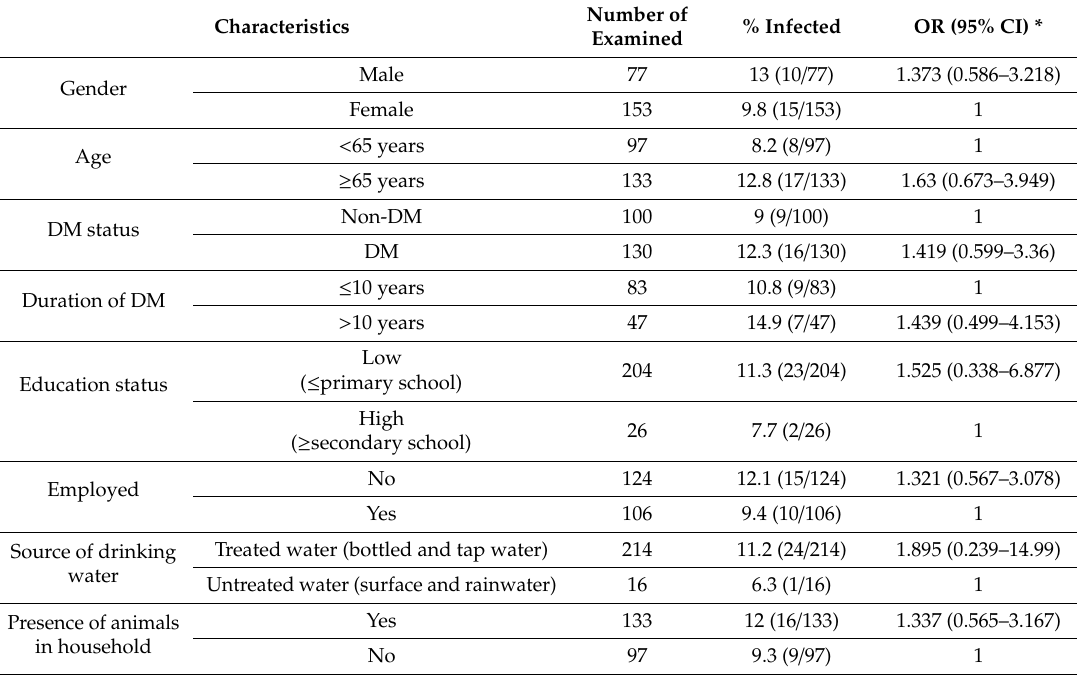
Table 3. Association between participant characteristics and Blastocystis infection in present study.